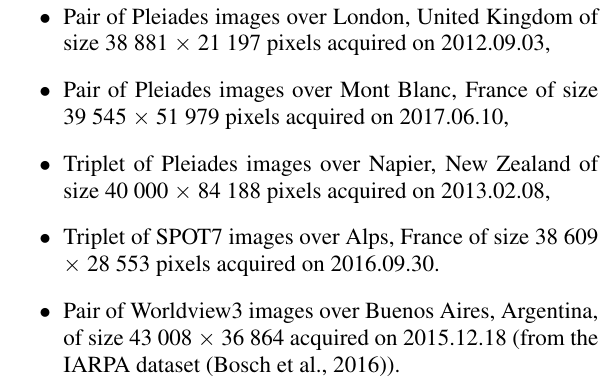
Figure 7. Detail of the final DSM for the PHR London case (see sec. 4.1). Elevation ranges from 42 m. (green) to 92 m. (brown).